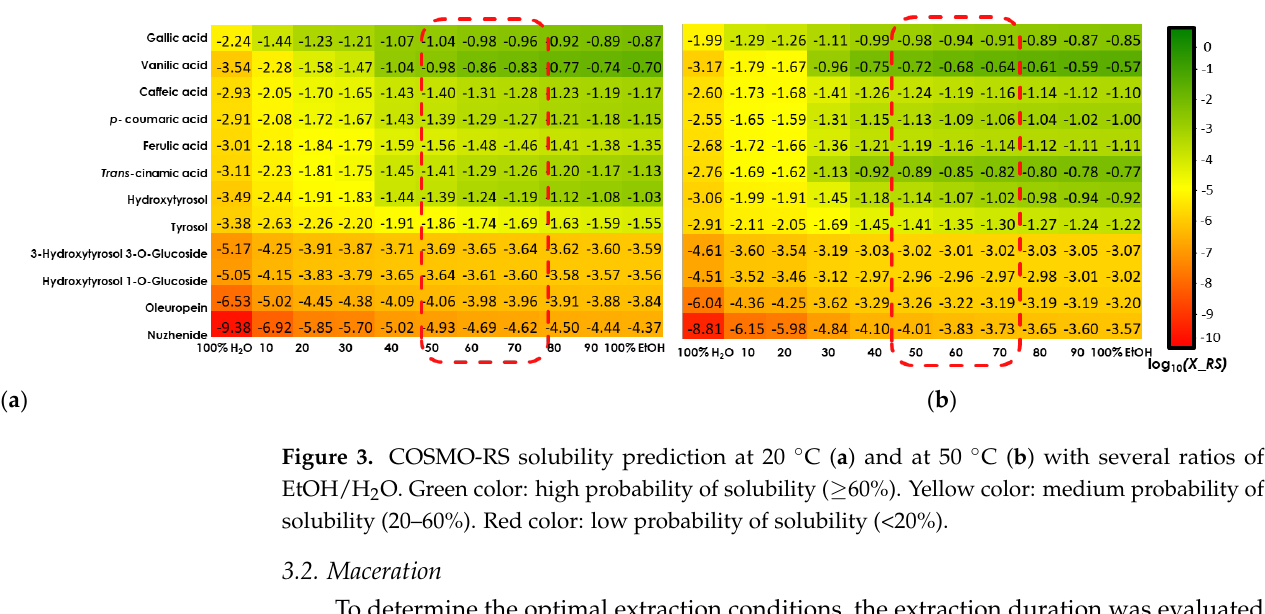
100% water. Nuzhenide followed by Oleuropein shows the lowest solubility values even in Biomolecules 2022 , 12 , x FOR PEER REVIEW 100% EtOH, as indicated by its medium solubility index. Figure 3. COSMO-RS solubility prediction at 20 °C ( a ) and at 50 °C ( b ) with several ratios of EtOH/H 2 O. Green color: high probability of solubility ( ≥60%) . Yellow color: medium probability of solubility (20 – 60%). Red color: low probability of solubility (<20%).